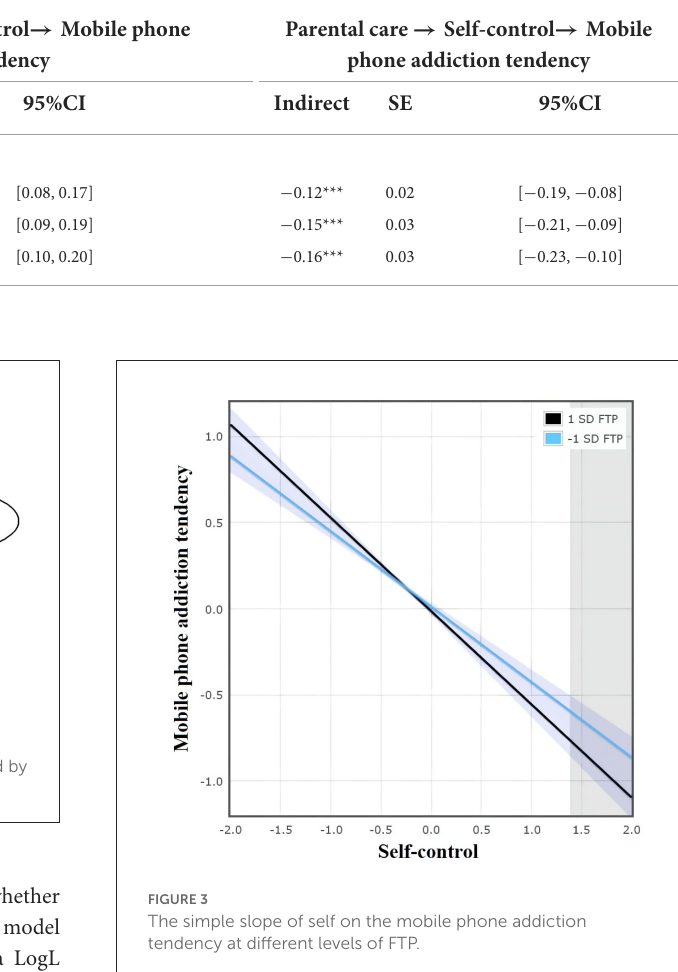
TABLE 4 Summary for the moderated mediation effect.